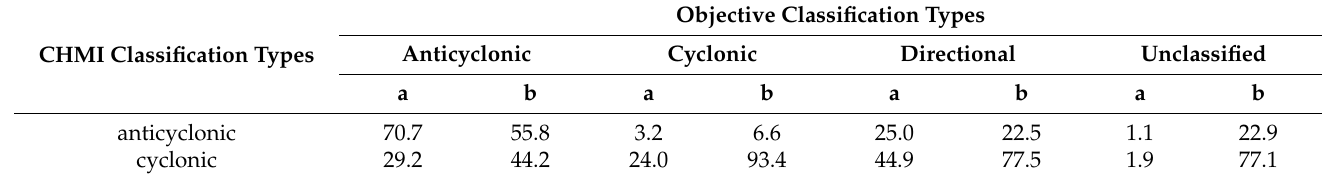
Table 2. Relative agreement (%) in frequencies of the occurrence of the anticyclonic, cyclonic, directional, and unclassified types under the objective classification during the occurrence of the anticyclonic and cyclonic types under the CHMI classification (a) and vice versa (b) in the 1961–2020